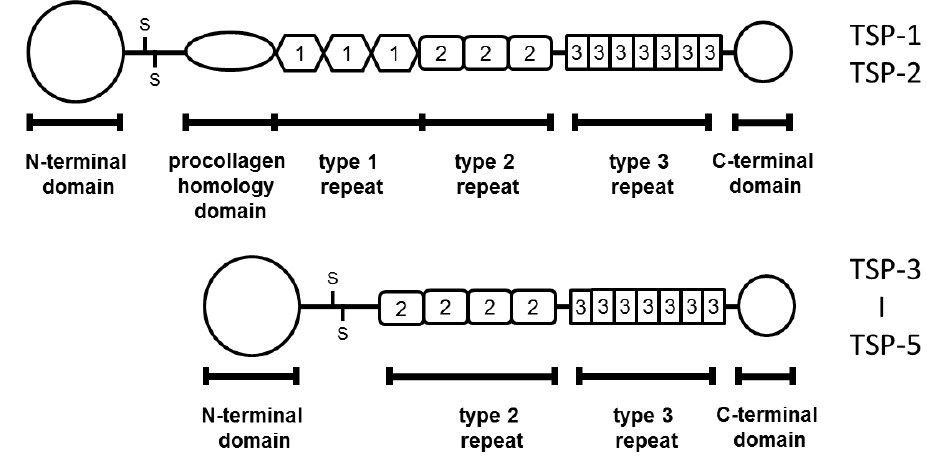
Figure 1. Structures of TSP members. Only TSP-1 and -2 have the type I repeat